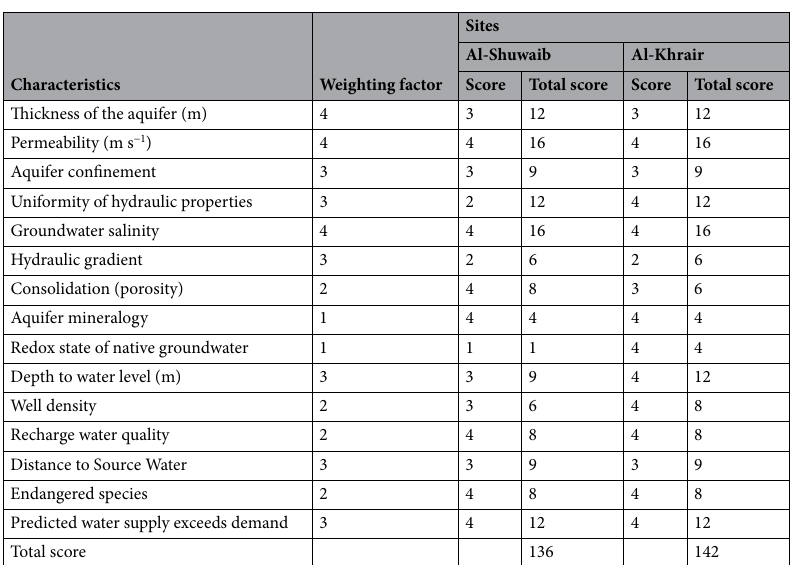
Characteristics Weighting